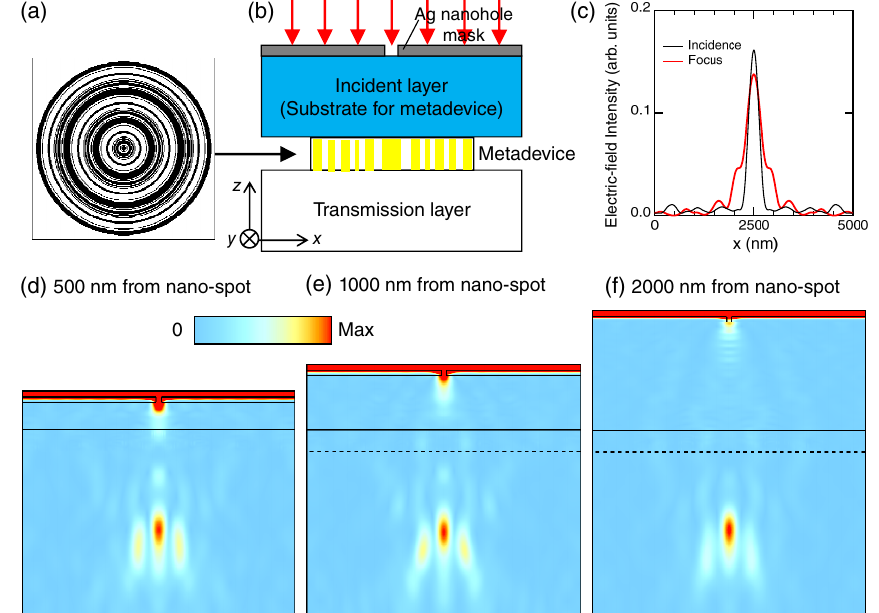
Figure 7. Focusing length-invariant metadevice made of the 1D metasurface found in Section 4. ( a ) The focusing metadevice structure; ( b ) a test configuration for the metadevice, in which the Ag nanohole mask is introduced to induce an incident light spot; red arrows denote incident light; ( c ) electric field intensity profiles at incident and focal spots; the black curve shows the section of the incident spot and red that of the focal spot; ( d – f ) the metadevice is placed at a distance of 500, 1000, and 2000 nm from the 100 nm width nanospot, respectively; Poynting fluxes | S | are plotted in the configuration ( b ); in ( c – f ), the incident photon energy was set to be 2.75